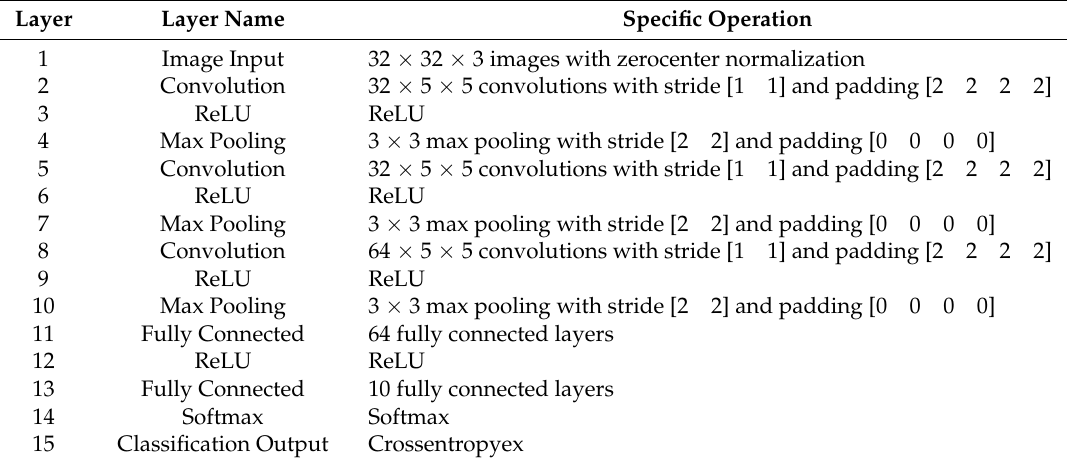
Table 2. Whole CNN Structure of R-CNN